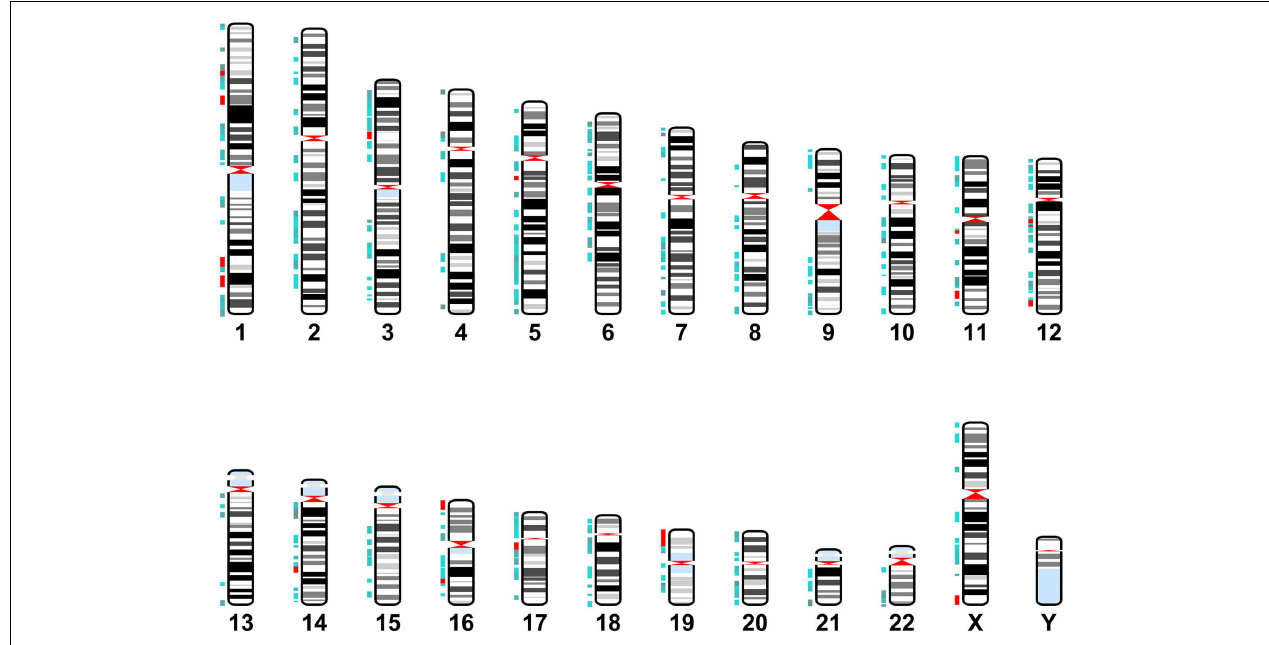
FIGURE 2 | miR-137 target gene locations . Karyotype representing cytoband locations of the miR-137TargetScan putative target genes. Blue depicts cytobands with two to five target genes. Red indicates regions containing six or more target